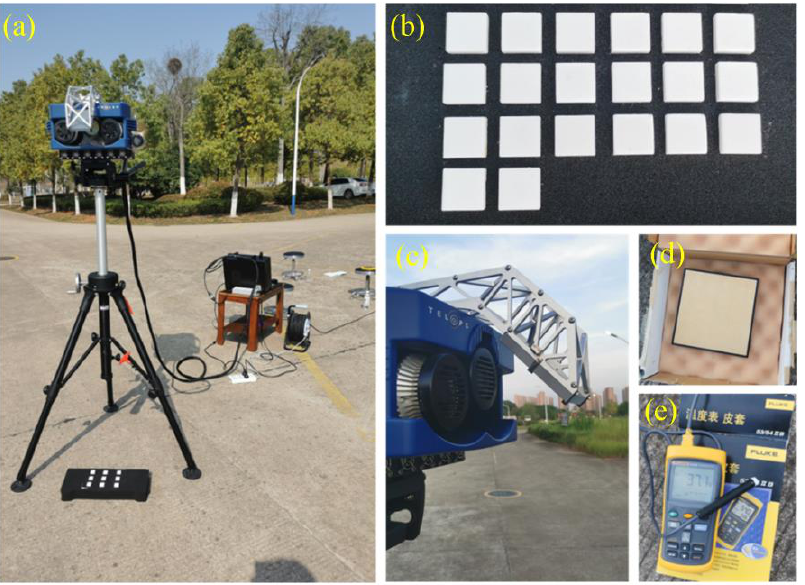
Figure 5. Conditions for collectingTIH data of potassium salt samples. ( a ) Sample shooting; ( b ) Potassium salt sample; ( c ) Hyper-Cam lens; ( d ) Gold-plate; ( e ) Thermometer.